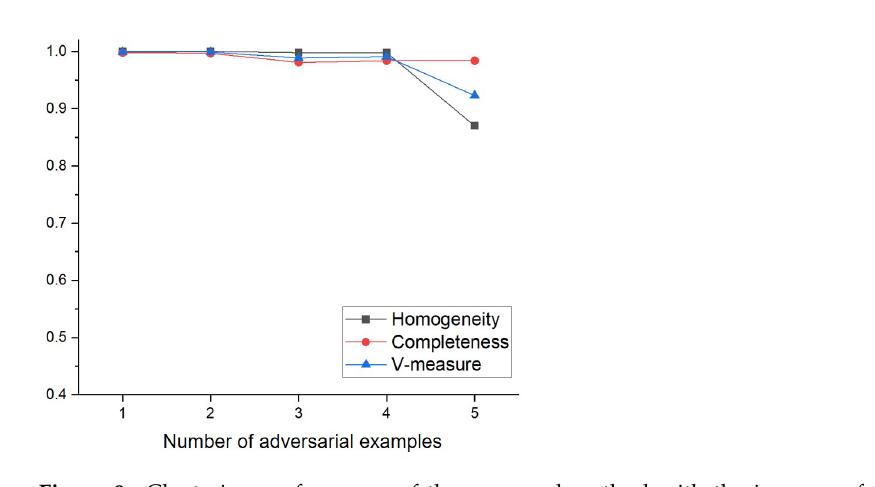
Figure 8. Clustering performance of the proposed method with the increase of the number of adversarial examples using MNIST